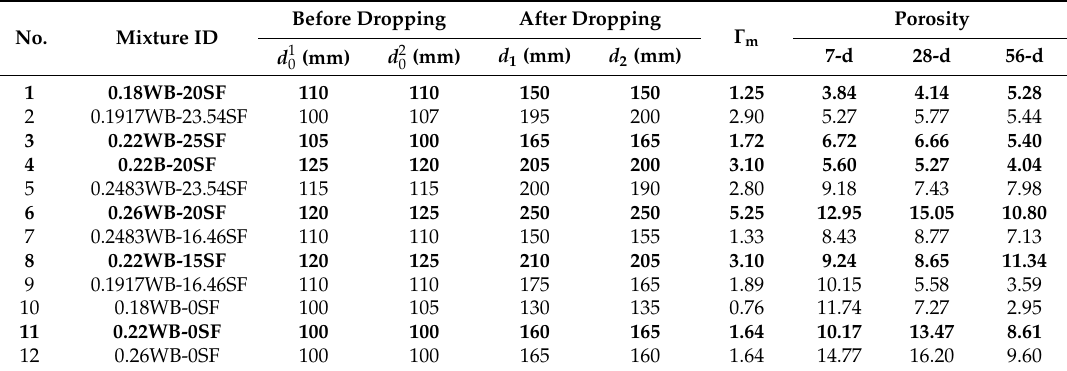
Table 3. Flowability and porosity test